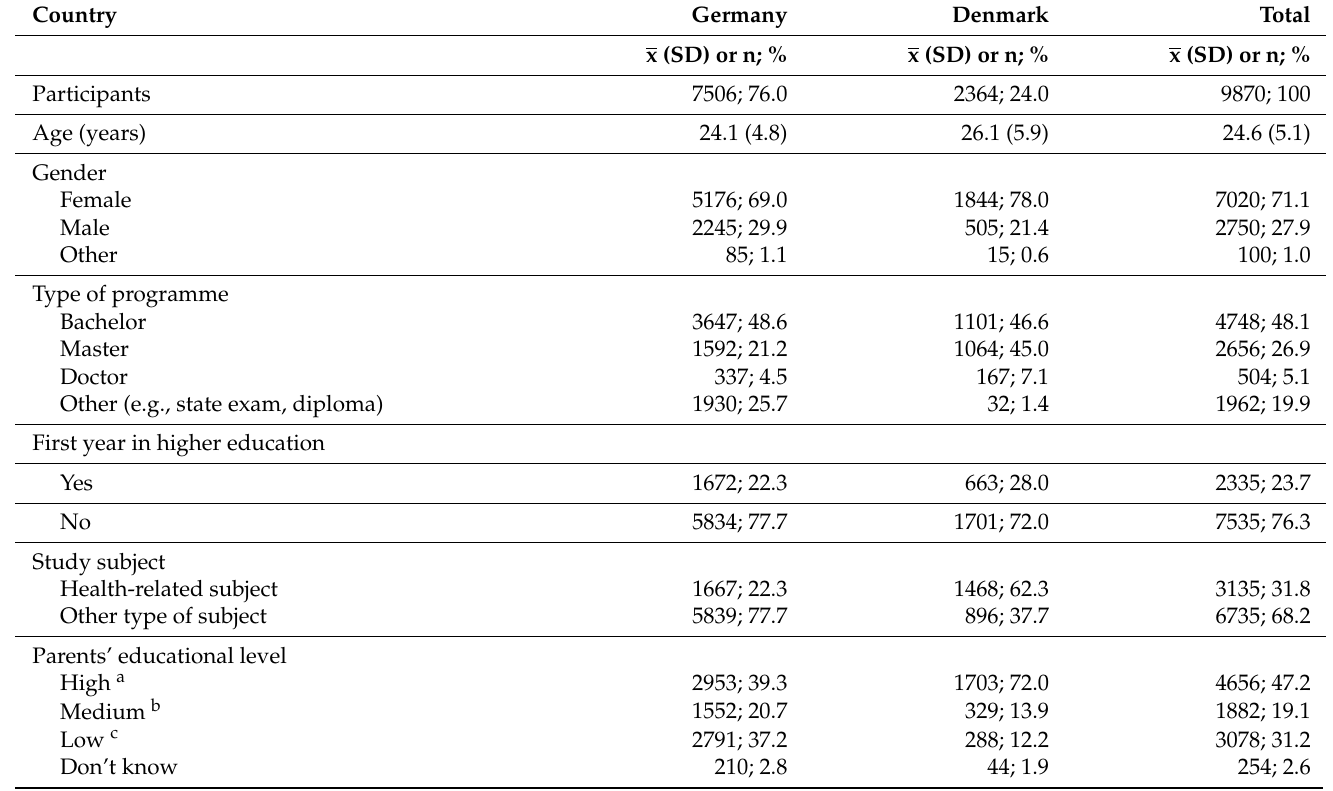
Table 1. Sociodemographic sample characteristics of students in seven universities in Germany and Denmark, n = 9870, C19 ISWS survey,